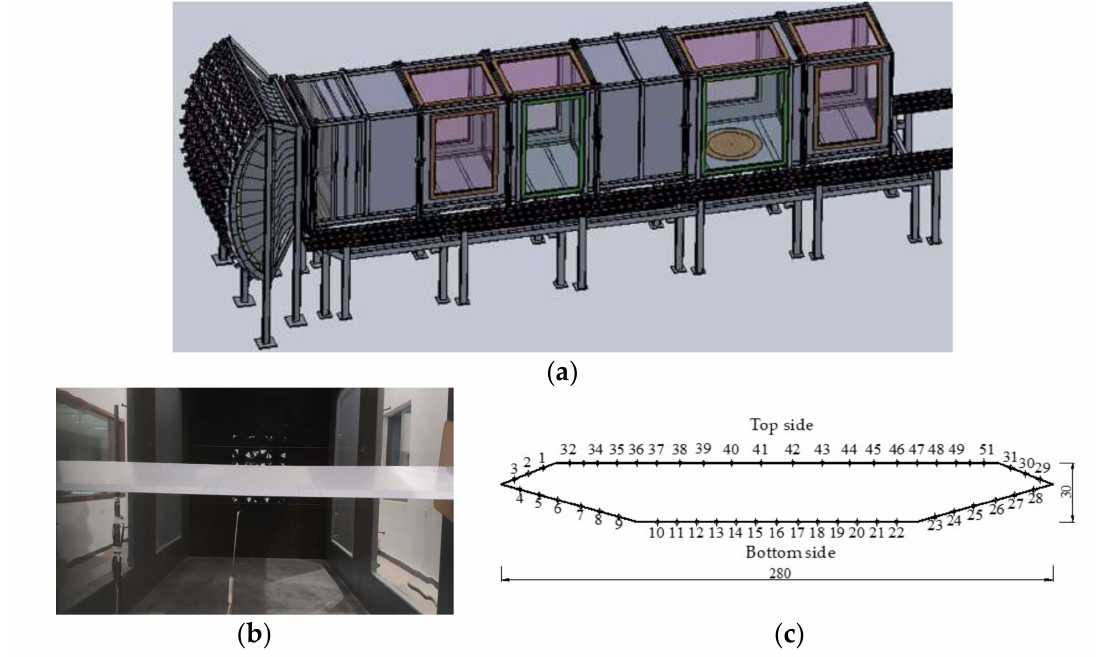
Figure 1. Wind tunnel setups. ( a ) active-control wind tunnel; ( b ) tested cross-section; ( c ) schematic diagram of the pressure taps (unit: